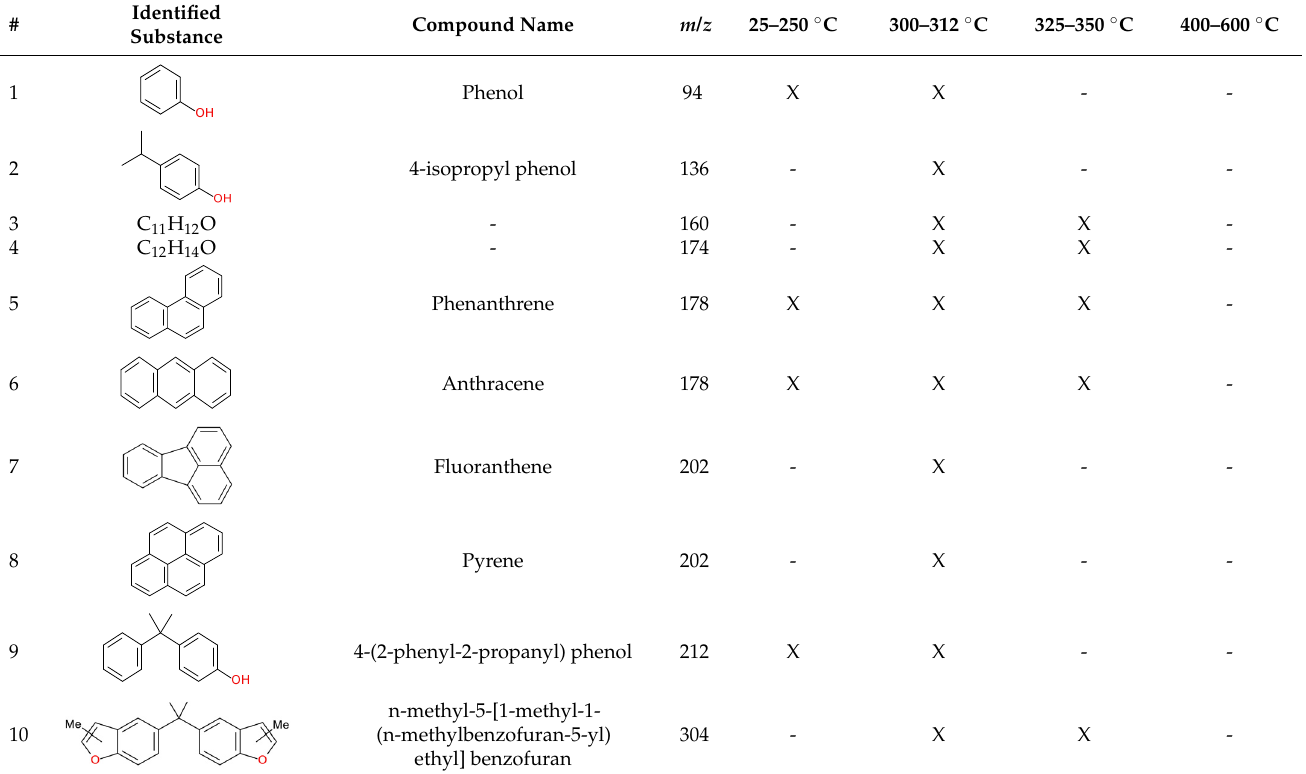
Table 3. Organic compounds detected in the inhalable PM fractions PM 2.5 and PM 10 formed during dry-cutting of thermally stressed C 3 (25–600 °C, air atmosphere, 3 h). Differences between PM 2.5 and PM 10 occurred only in the signal intensities. The compounds were observed by TOCA-REMPI-MS and evaluated by comparison with the Py-GC-EI-QMS and TA-APPI-MS data.